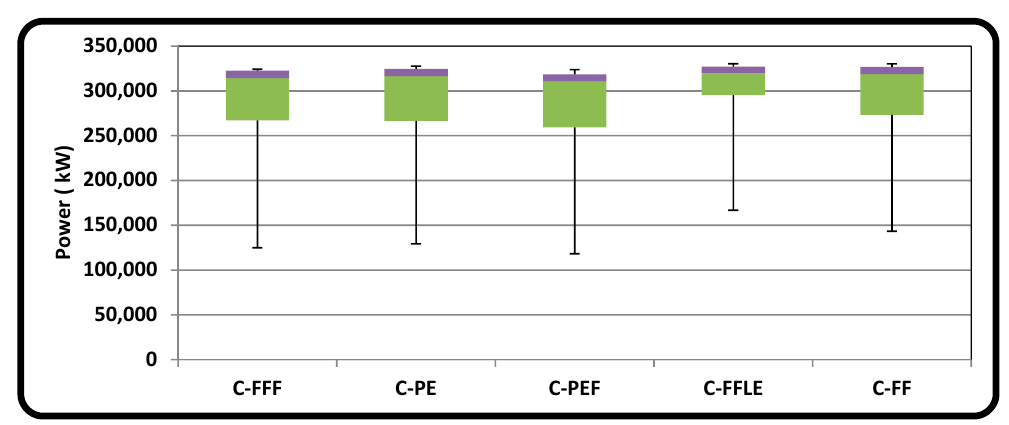
Appl. Sci. 2020 , 10 , x FOR PEER REVIEW